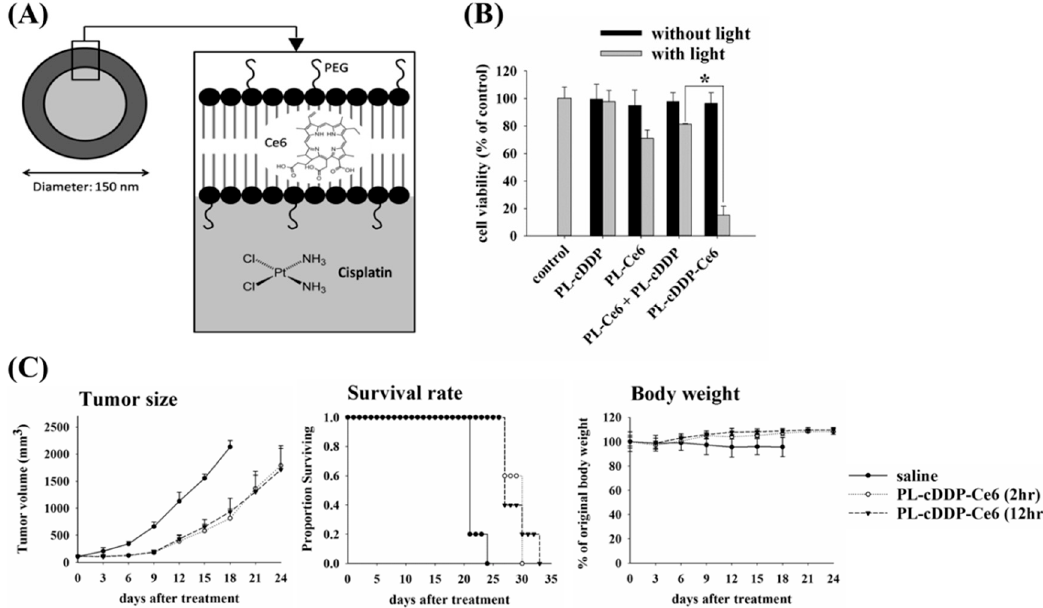
Figure 5. ( A ) Diagram of dual-e ff ect liposome (PL-cDDP-Ce6) with cisplatin (cDDP) and Ce6 encapsulated in the interior and lipid bilayer, respectively. ( B ) In vitro cytotoxicity under the impact of di ff erent liposomal drugs. A375 cells were incubated with PL-Dox-Ce6, PL-cDDP, PL-Ce6, and the combination of PL-Ce6 and PL-cDDP. The concentration of Ce6 and cDDP is 0.5 and 1.12 mg / mL, respectively. After incubation for 2 h, cells were irradiated with light (0.1 J / cm 2 ) and cell viability was determined by MTT assay 24 h after light irradiation (* p < 0.05). ( C ) Tumor growth control of PL-cDDP-Ce6 (Ce6: 1.75 mg / kg; cisplatin: 3.72 mg / kg). After drug injection, light irradiation (100 J / cm 2 ) was given at 2 h and 12 h, respectively. Left panel, tumor size; Middle panel, survival rate; Right panel, body weight. The results are represented as the mean ± S.D. for each group ( N = 5).